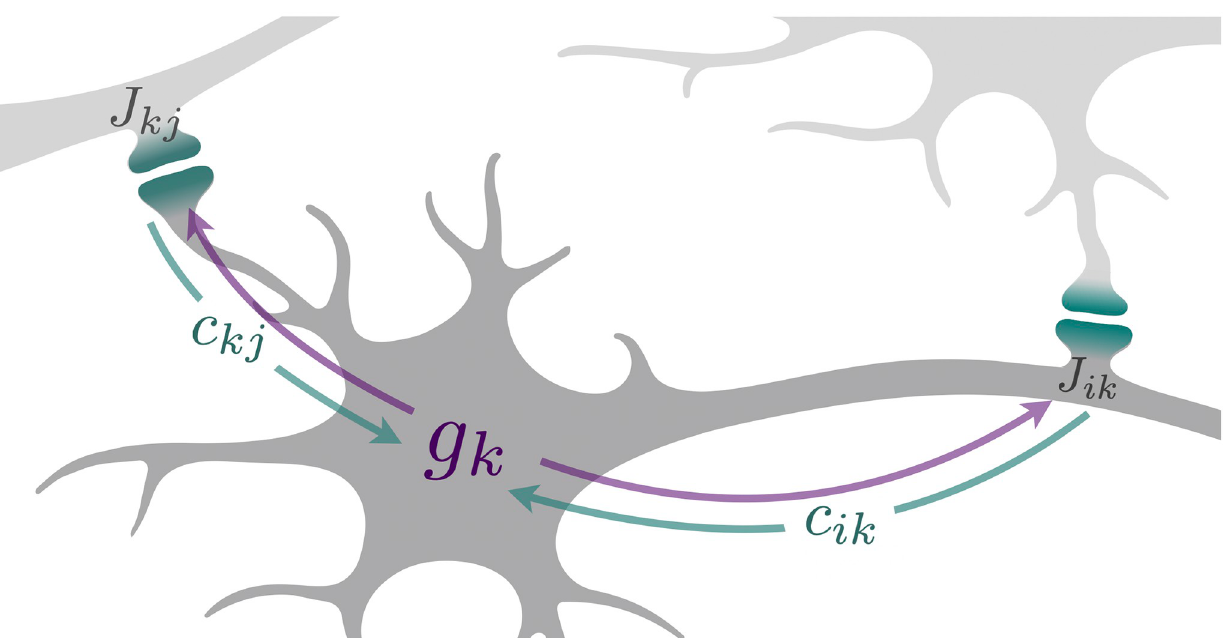
Fig 2. The local computations underlying synaptic balancing. Each synapse (indicated in teal) calculates a cost as a function of synaptic strength, as in (13). Neuron k receives signals of incoming synaptic cost c and outgoing synaptic cost c (teal arrows from synapses to soma) and computes the difference kj ik g k as in (17). The signal g k then propagates outwards (purple arrows from soma to synapses) to modify the strength of incoming and outgoing synaptic connections, as in (18), such that the total incoming and total outgoing costs are eventually balanced in every neuron.